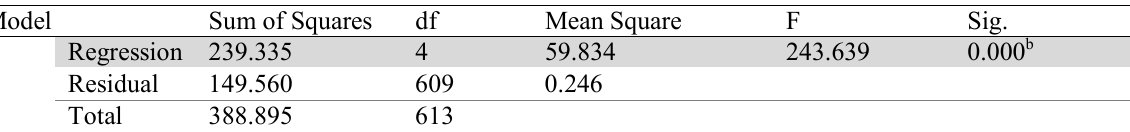
Coefficients a Model